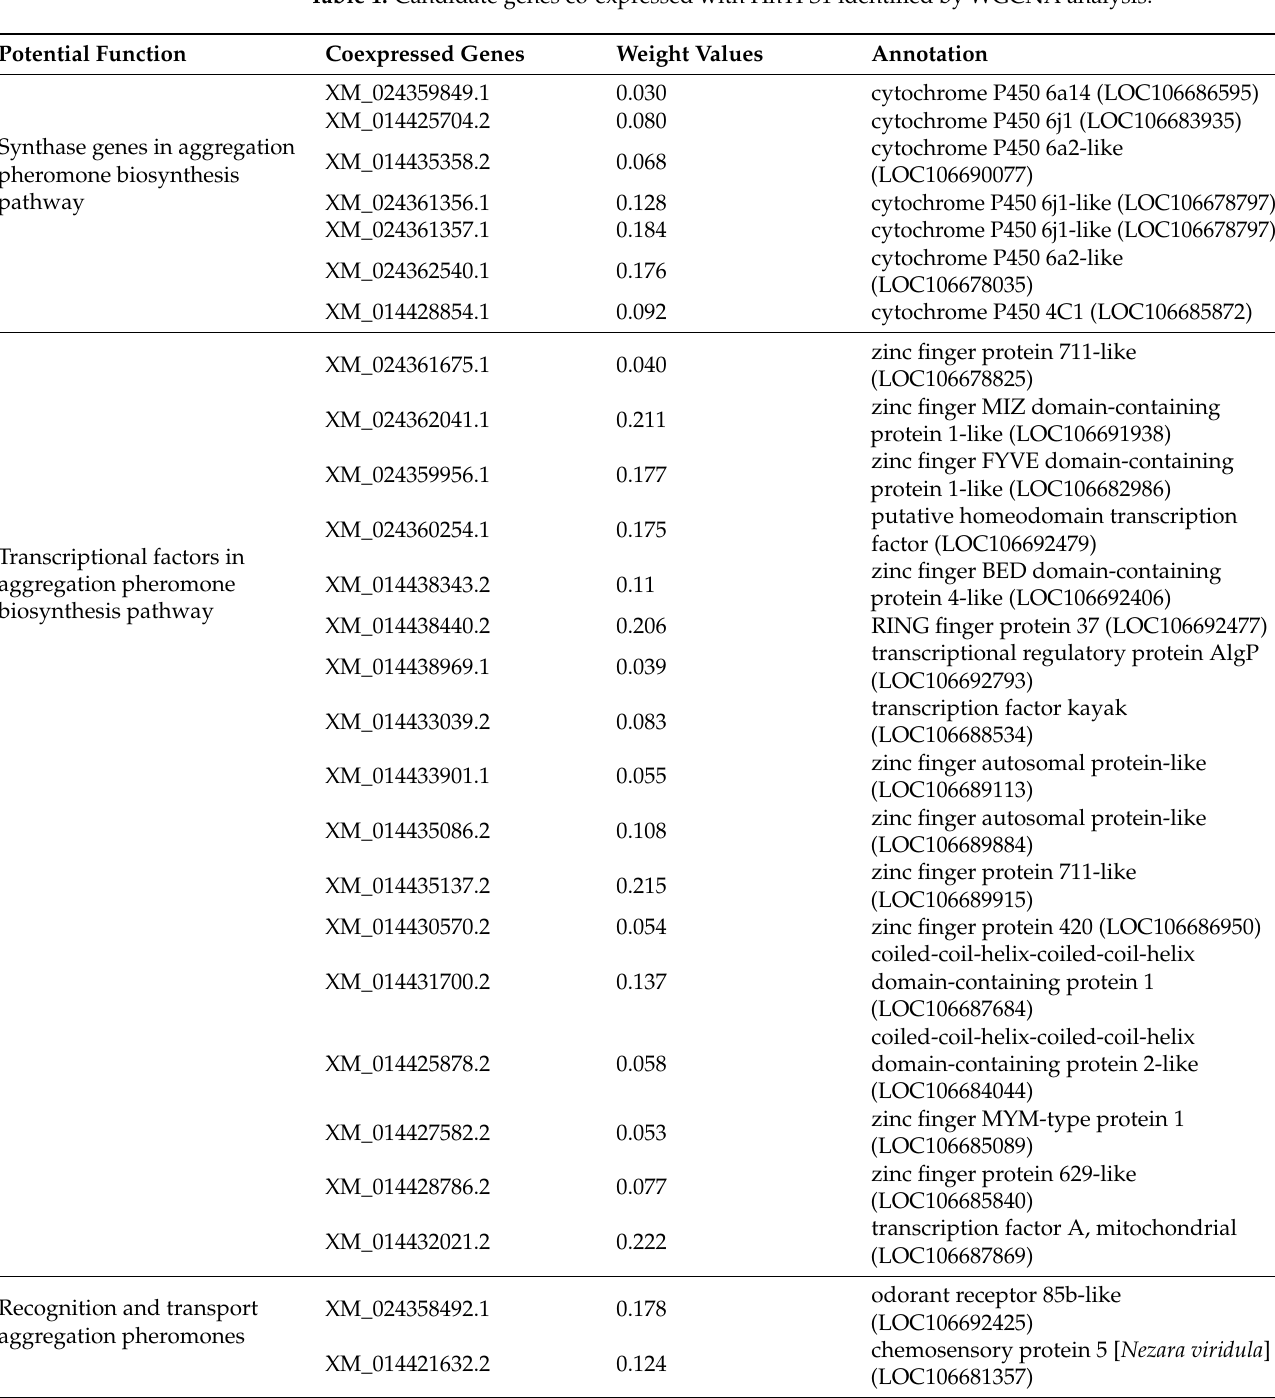
Table 1. Candidate genes co-expressed with HhTPS1 identified by WGCNA